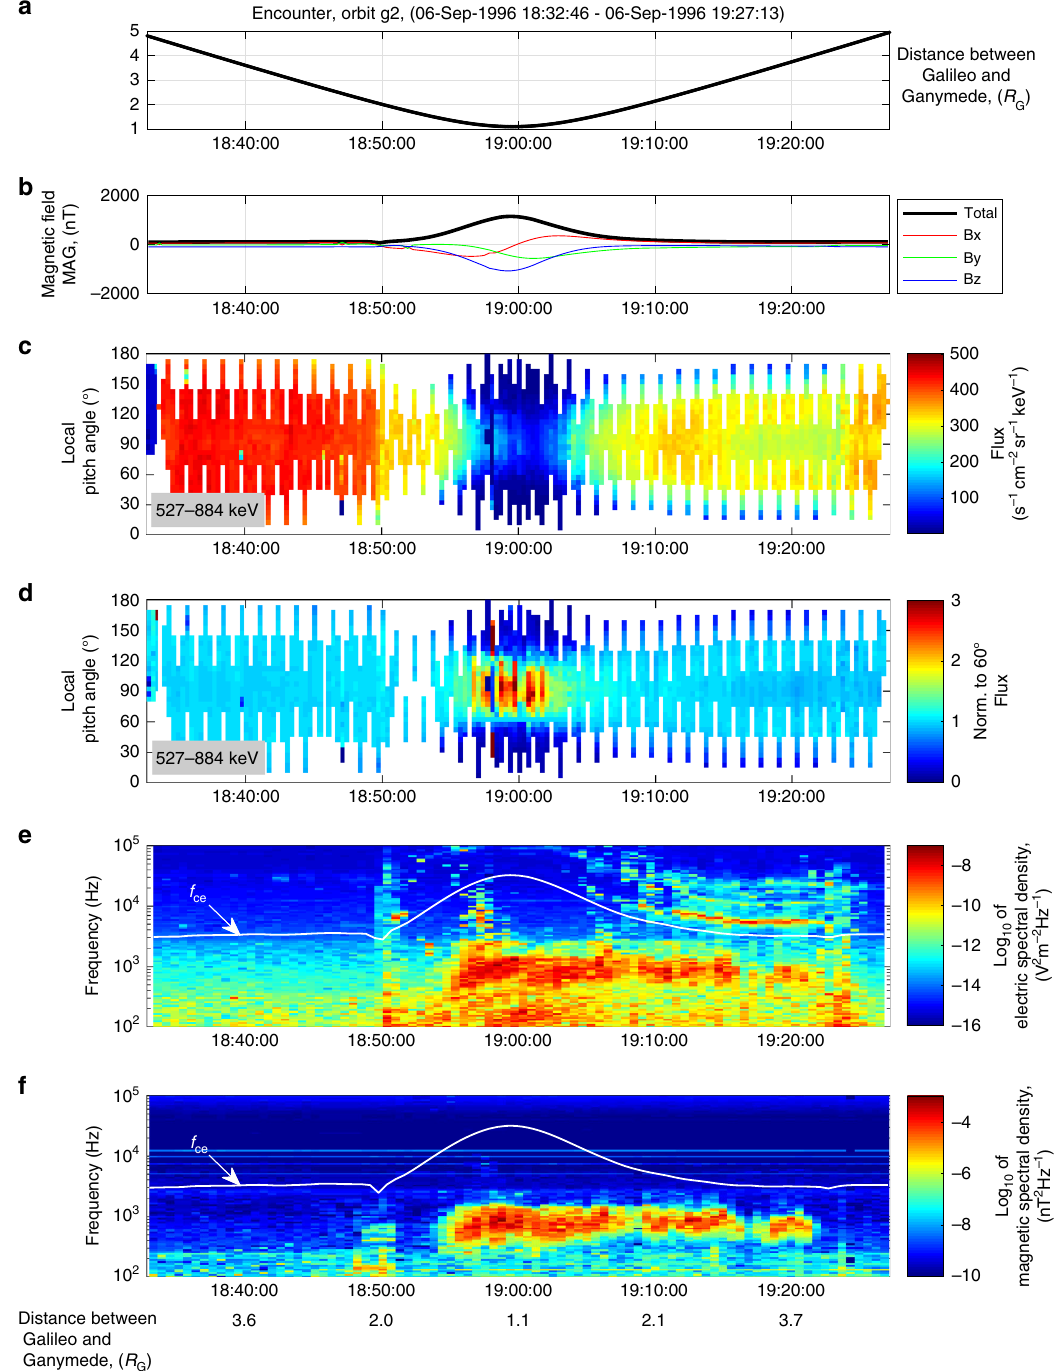
Fig. 2 Comparison of wave power and pitch angle distributions for the encounter on 6 September 1996 (orbital segment G2). a The distance between Ganymede and the Galileo spacecraft, b measurements of the magnetic fi eld, c pitch angle distribution of 527 – 884 keV electron fl uxes, d same as c but normalized by the value of fl uxes at 60° local pitch angle, e dynamic spectrogram of electric fi eld very low frequency (VLF) spectral density, f dynamic spectrogram of magnetic fi eld VLF spectral